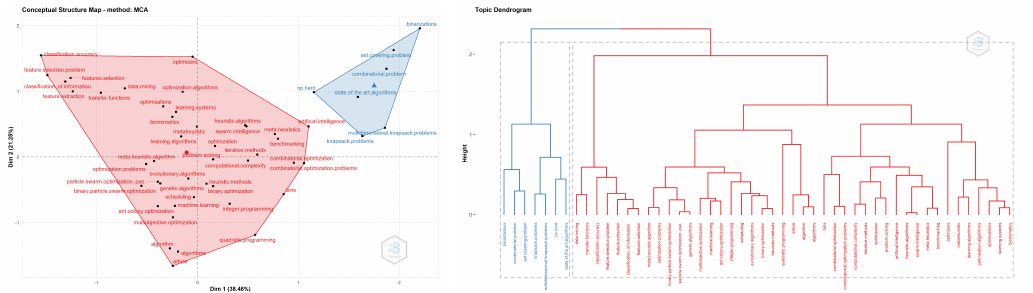
Figure 6. Conceptual bigrams